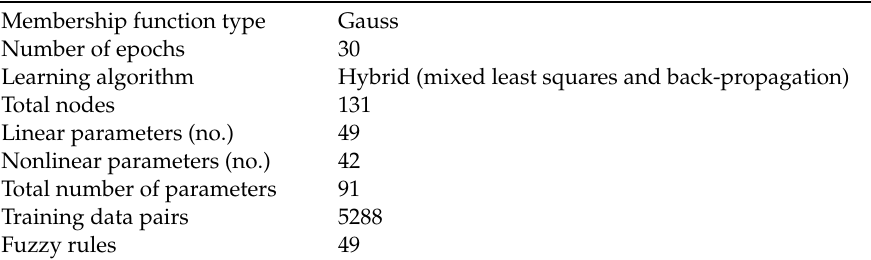
Figure 7. ANFIS training data outcome and control surface. ( a ) Training data outcome. ( b ) Suggested ANFIS control surface.